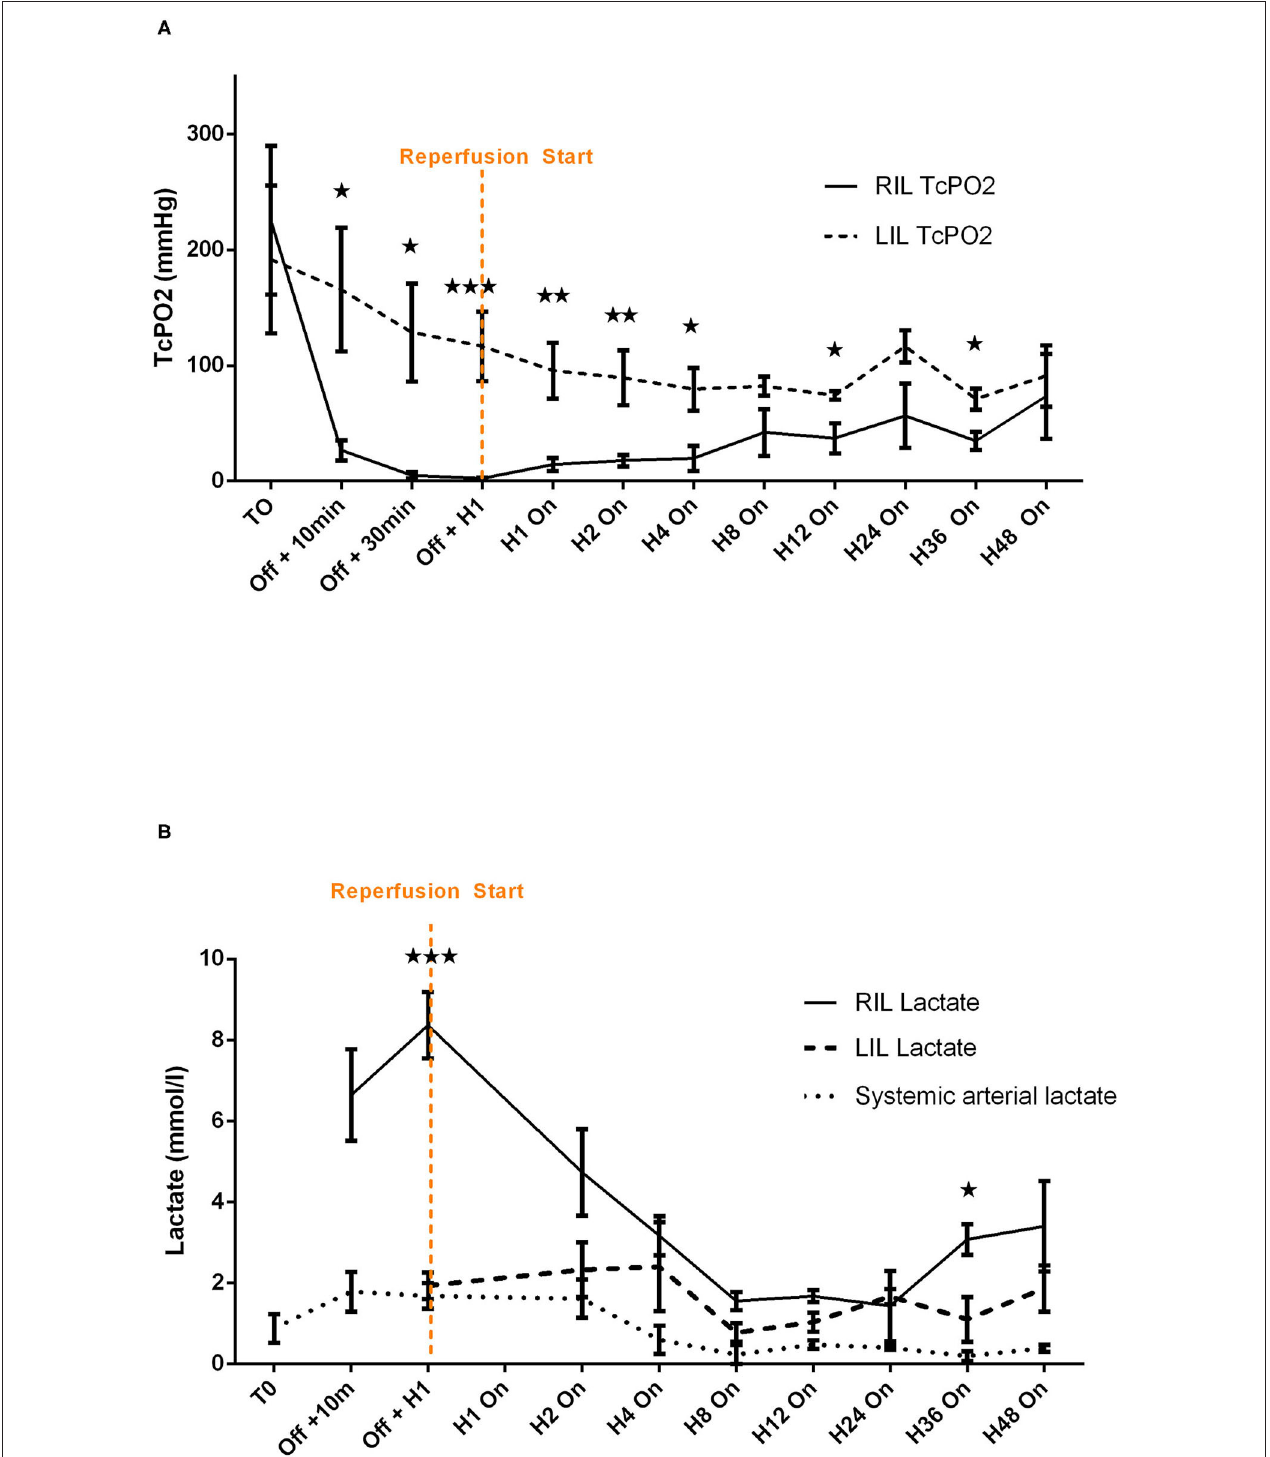
FIGURE 3 | Comparative analysis of transcutaneous pressure in oxygen (A) and lactate (B) evolution before and after reperfusion start in healthy pigs. Transcutaneous pressure in oxygen (TcPO 2 ) are presented at each time points by mean ± SEM ( n = 6). The values of p were obtained by comparing RIL (IVAC2L) and LIL. ⋆ p < 0.05; ⋆⋆ p < 0.01, and ⋆⋆⋆ p < 0.001. T0, basal measure after sedation; H1, 1h post reperfusion On; H4, 4h after reperfusion On; H8, 8h after reperfusion On; H12, 12h after reperfusion On; H24, 24h after reperfusion On; H36, 36h after reperfusion On; H48, 48h after reperfusion On; LIL, left inferior leg; n , number of pigs; Off, Solopath inserted but reperfusion Off; RIL, right inferior leg; SEM, standard error of mean; TcPO 2 , transcutaneous pressure in oxygen.